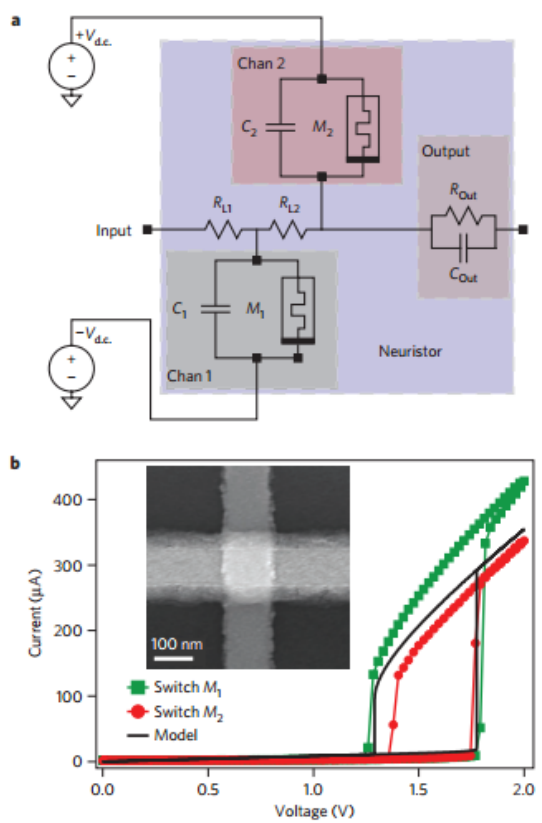
Figure 10: Neuristor diagram and Mott memristor device characteris- tics. (a) Schematic of the lumped neuristor. The channels comprise of Mott memristors ( M 1 and M 2 ) in parallel with capacitance ( C 1 and C 2 , respectively) and are biased with opposite polarity d.c.